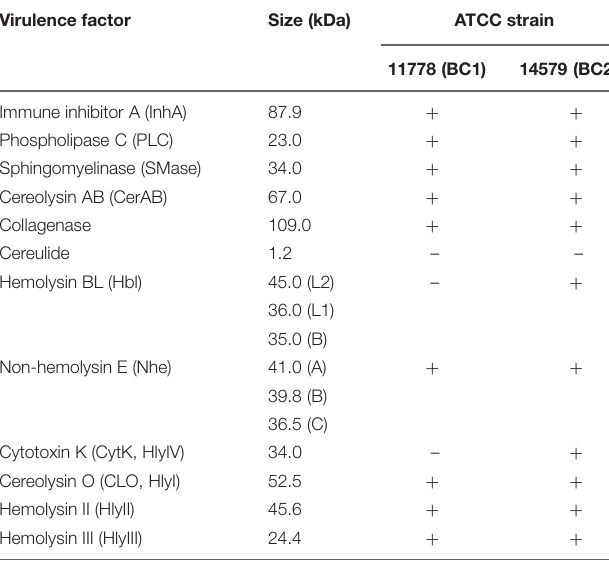
TABLE 1 | Virulence factors in B. cereus ATCC 11778 and